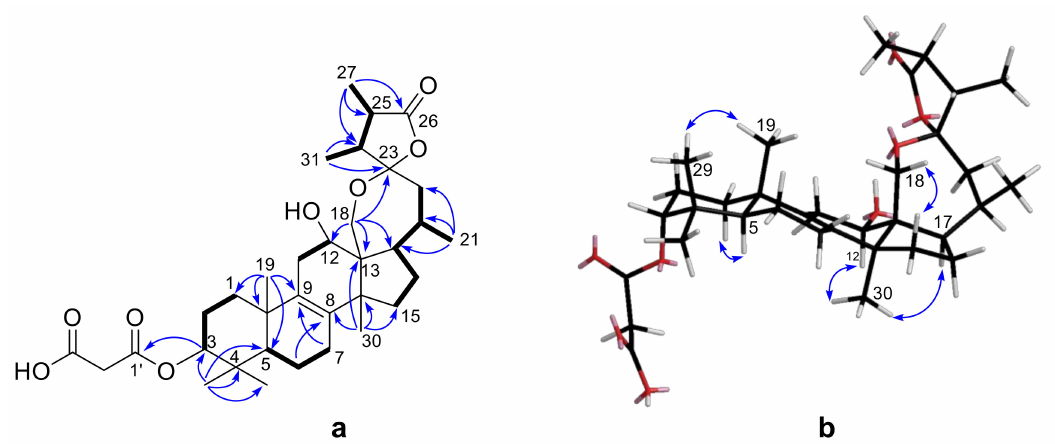
Figure 2. ( a ) Key 1 H − 1 H COSY ( — ) and selected HMBC correlations (H → C) of 1 ; ( b ) selected NOESY correlations (H ↔ H) of 1 .